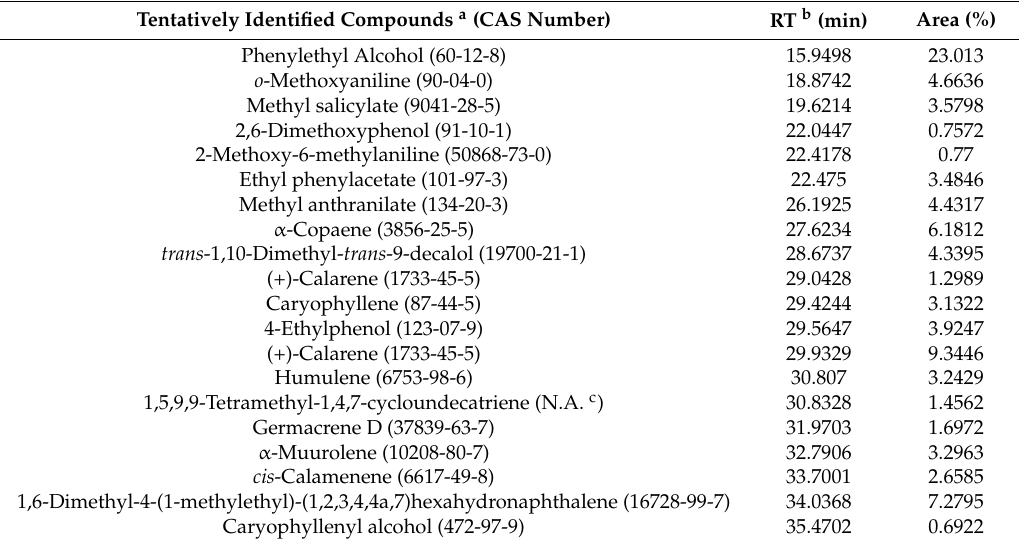
Table 3. Volatile compounds identified from 21 d culture of S. fimicarius